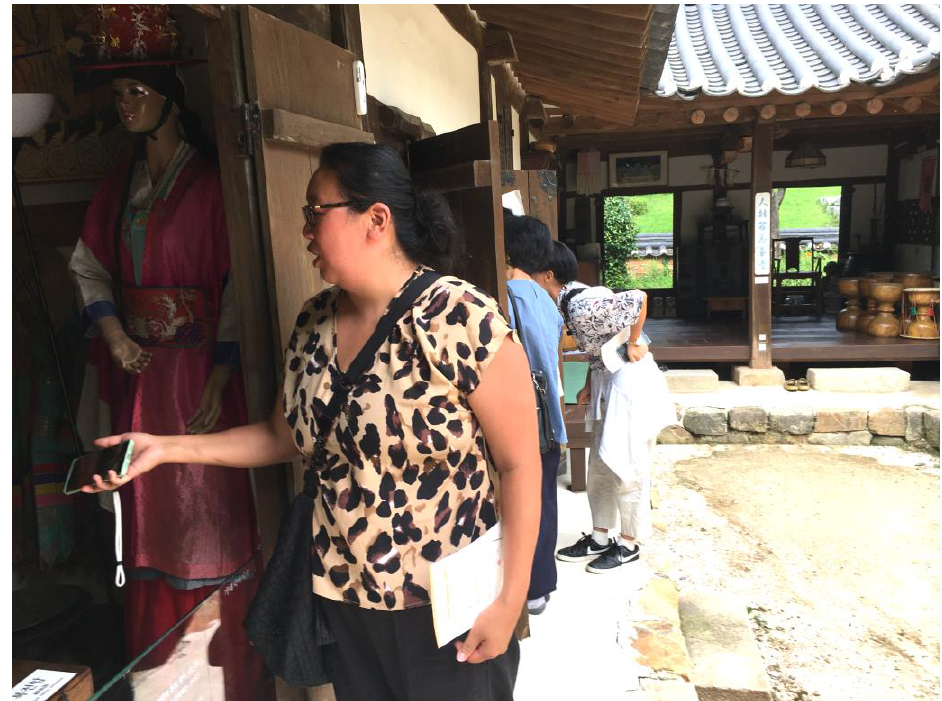
Figure 9. Mudang Jenn during her visit in the Shamanism Museum in Seoul. July 2022, the photo- graph was taken by the author with consent from the people depicted..